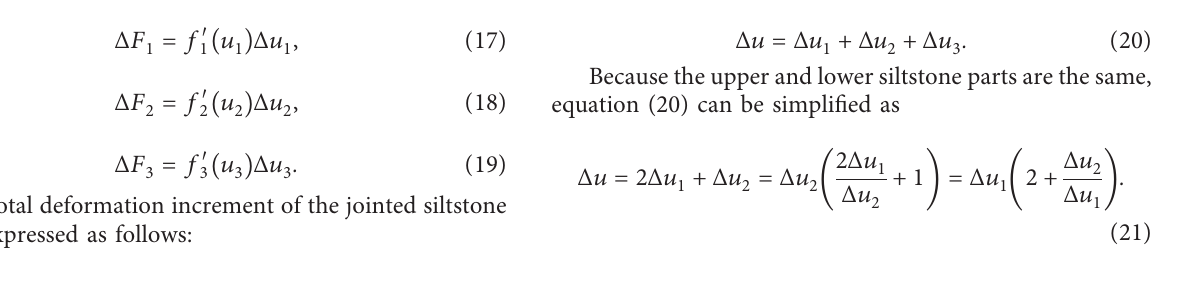
Figure 6: Failure forms of siltstone in the structural planes with different thickness under uniaxial compression. Specimens of (a) intact siltstone or jointed siltstone with (b) 5 mm, (c) 10 mm, (d) 15mm, and (e) 20mm thick